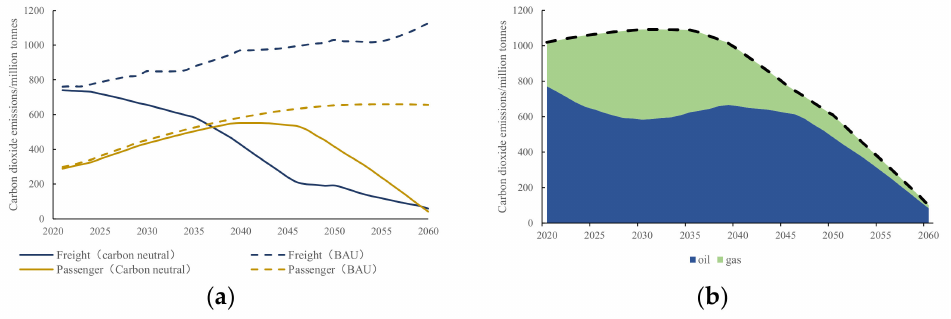
Figure 9. CO 2 emissions from the transport sector. ( a ) CO 2 from freight and passenger transport. ( b ) CO 2 from oil and gas.